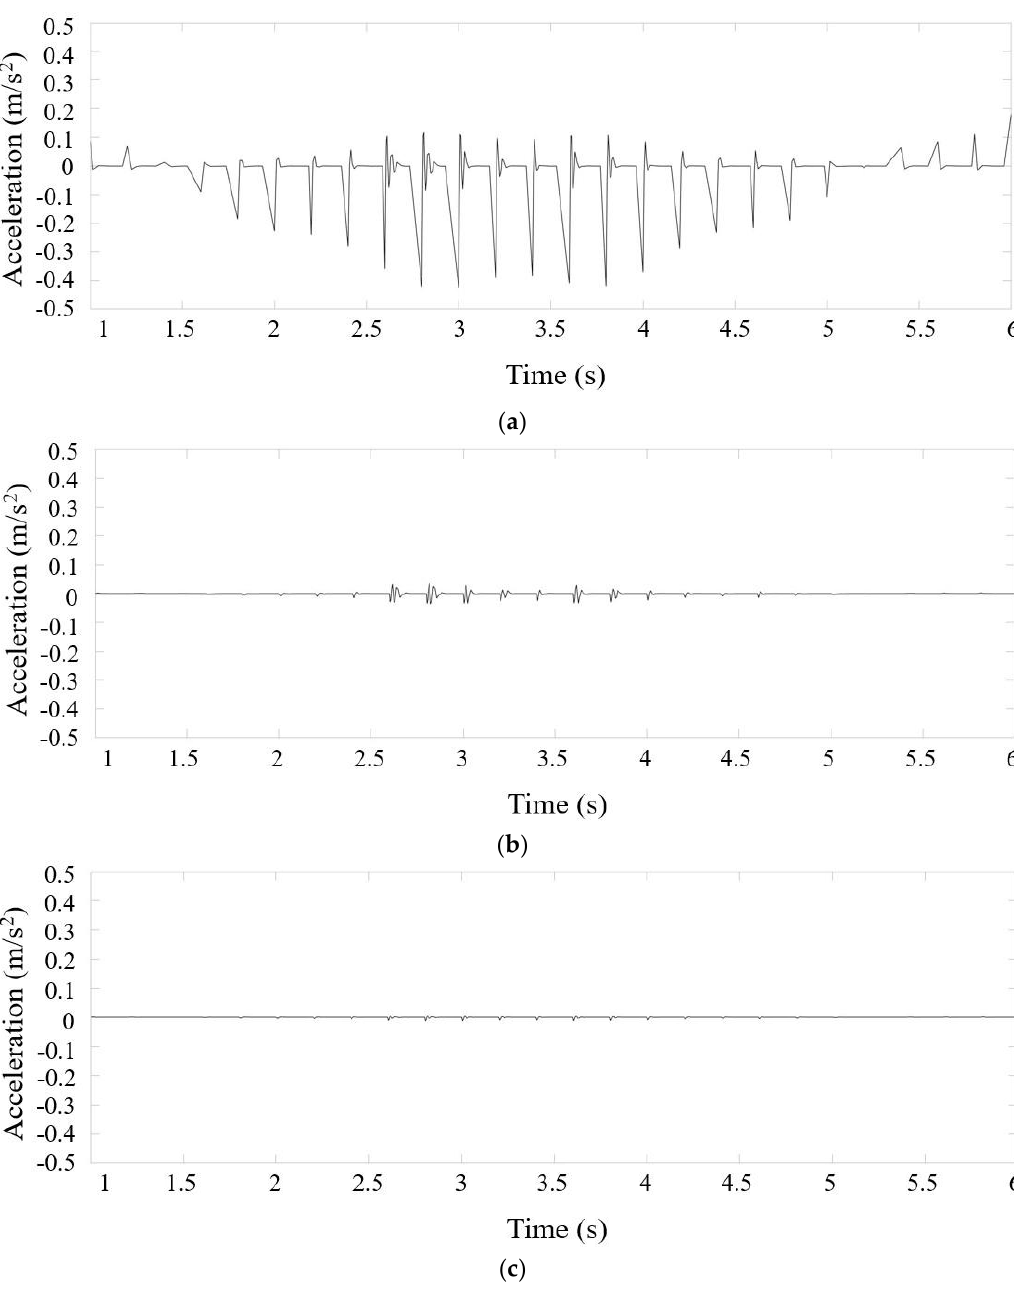
Figure 12. The vertical accelerations of the swing shaft ( a ), the lower die ( b ) and the frame ( c ). The realization of the vibration-control algorithms: the operational control of the COF machine system is carried out by the communication between the HMI touch screen and the PLC controller. The PLC controller generates corresponding communication signals according to the parameters set by the touch screen and transmits them to the proportional servo valve, linking the PLC controllers of the computer and the COF machine and importing the vibration-control algorithms into the PLC controller of the computer. After that, the PLC controller of the COF machine is imported into the vibration-control algorithms. Ultimately, the operation of the COF machine is affected by the vibration-control algorithms. The vibration-control algorithms are realized, and the vibration of the COF machine is reduced.